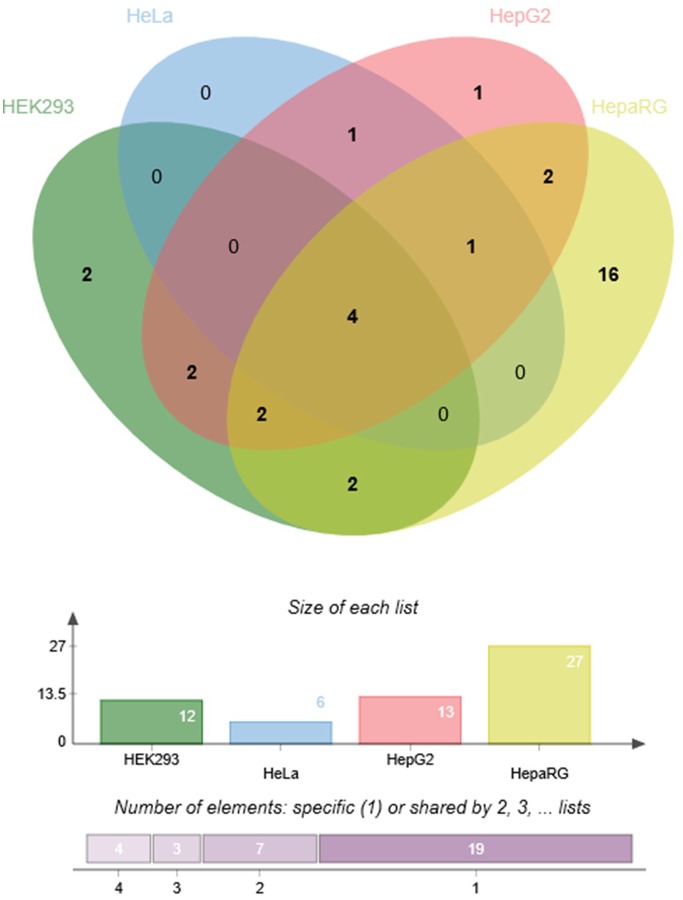
Cell line-specificity of functional mirSNPs in pharmacogenes. Venn diagram (Bardou et al., 2014) showing the number of unique and overlapping functional mirSNPs in the four cell lines tested.